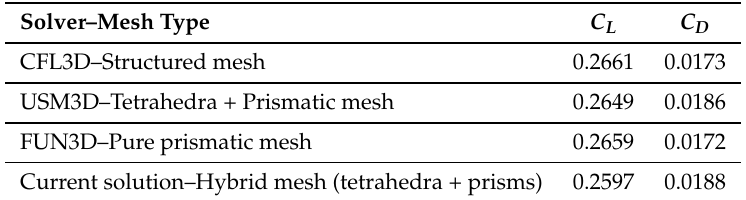
Table 3. Comparison of C L and C D obtained with different solvers (data taken from reference [24]). The comparison is done for meshes with similar cell